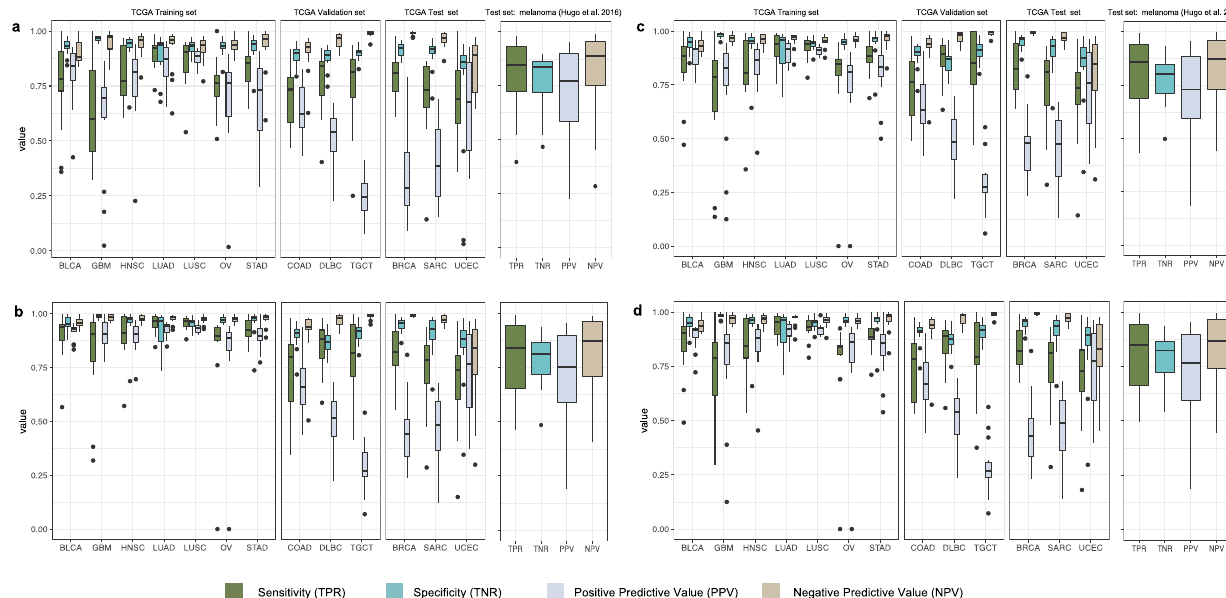
Fig. 2 Patient-level performance of the classi fi ers across tissue types. Four accuracy metrics for TCGA datasets. n = 15 randomly selected cancer patients per tissue type. The tabular machine-learning (ML) classi fi ers were trained on BLCA, GBM, HNSC, LUAD, LUSC, OV, STAD studies, all with Agilent Custom V2 exome-capture kit ( n = 105), validated on COAD, DLBC, and SARC studies, with SeqCap EZ HGSC VCRome capture kit ( n = 45), and tested on BRCA, SARC, and UCEC Nimblegen SeqCap EZ v3 capture kit ( n = 45) and the Hugo metastatic melanoma dataset ( n = 23 cancer patients sequenced by UCLA). Predictions made with a TabNet, b XGBoost, c LightGBM, and d the ensemble average of models. Boxplots depict the median (center line), fi rst and third quartiles (bounds of box), and maximum and minimum datapoints excluding outliers (whiskers). Outliers are datapoints more extreme than the box boundaries by a factor of 1.5 times the inner quartile